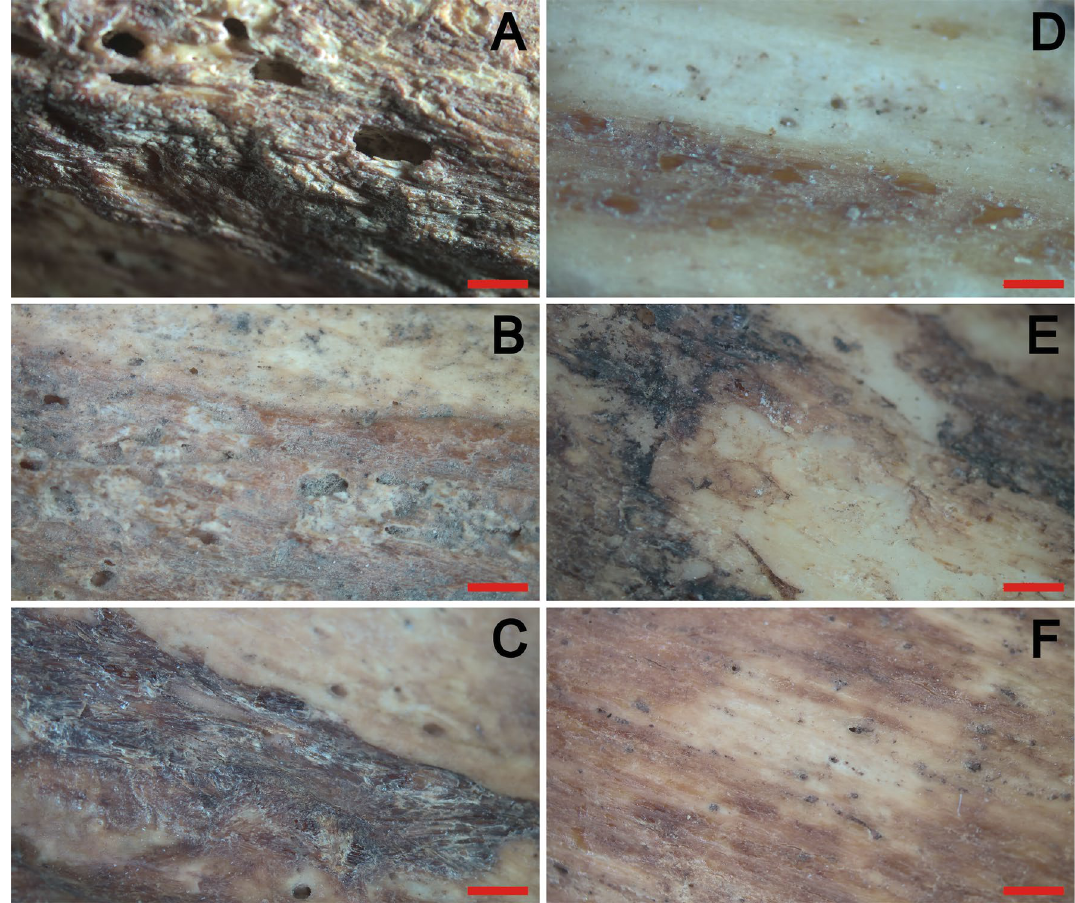
Figure 2. Periosteal bone of human archaeological femora. Microphotographs of periosteal bone of two human femora in different locations, as an example of the heterogeneity of the periosteal bone in terms of staining and presence of remaining soft tissue attached to the bone. ( A – C ) Individual SK400; ( D – F ) Individual SK4. Red lines indicate a scale of 2 mm in